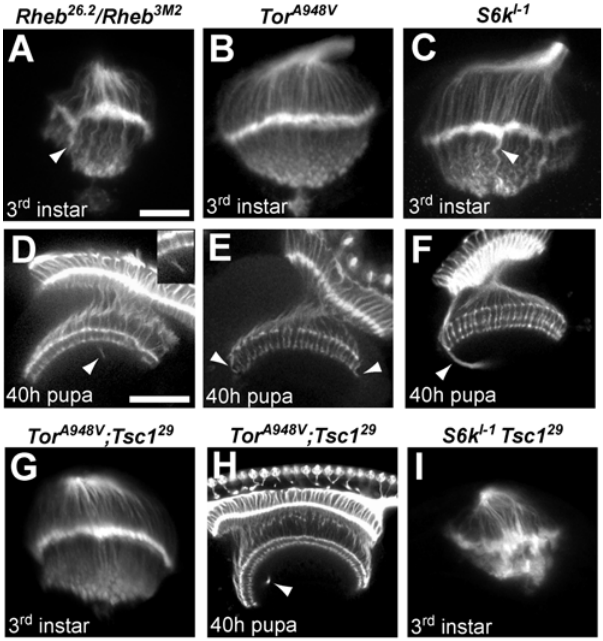
Figure 6. Effects of mutations that downregulate the Tor pathway on photoreceptor axon guidance, and genetic epistasis with Tsc1 . Optic lobes from third instar larvae (A–C) and 40h pupae (D–F) stained with MAb24B10. (A) Larvae heteroallelic for a hypomorphic combination of Rheb alleles show abnormal photoreceptor patterning and contain thick axon bundles that extend into the medulla (arrowhead). (D) At the 40 h pupal stage, Rheb mutants display axons that bypass their normal targets in the R7/R8 termination zones (arrowhead). (B) Larvae homozygous for a hypomorphic Tor allele show fairly normal photoreceptor patterning, but at the pupal stage (E) misrouted axons can be seen in the medulla (arrowheads). (C) S6k null homozygous larvae show thick axon bundles projecting past the lamina (arrowhead), while S6k pupae (F) display misrouted axons that initially bypass the R7/ R8 termination zone (arrowhead). (G, H) Animals doubly mutant for Tor and Tsc1 do not show the severe photoreceptor defects seen when axons are mutant for Tsc1 alone (compare to Figure 5B, F, F 9 ), although mild defects similar to those in Tor mutants are still apparent (arrowhead). (I) S6k-Tsc1 double homozygous mutants display a severe phenotype dissimilar to mutants for either S6k or Tsc1 alone. The scale bar is 25 microns in panel A, 50 microns in panel D.